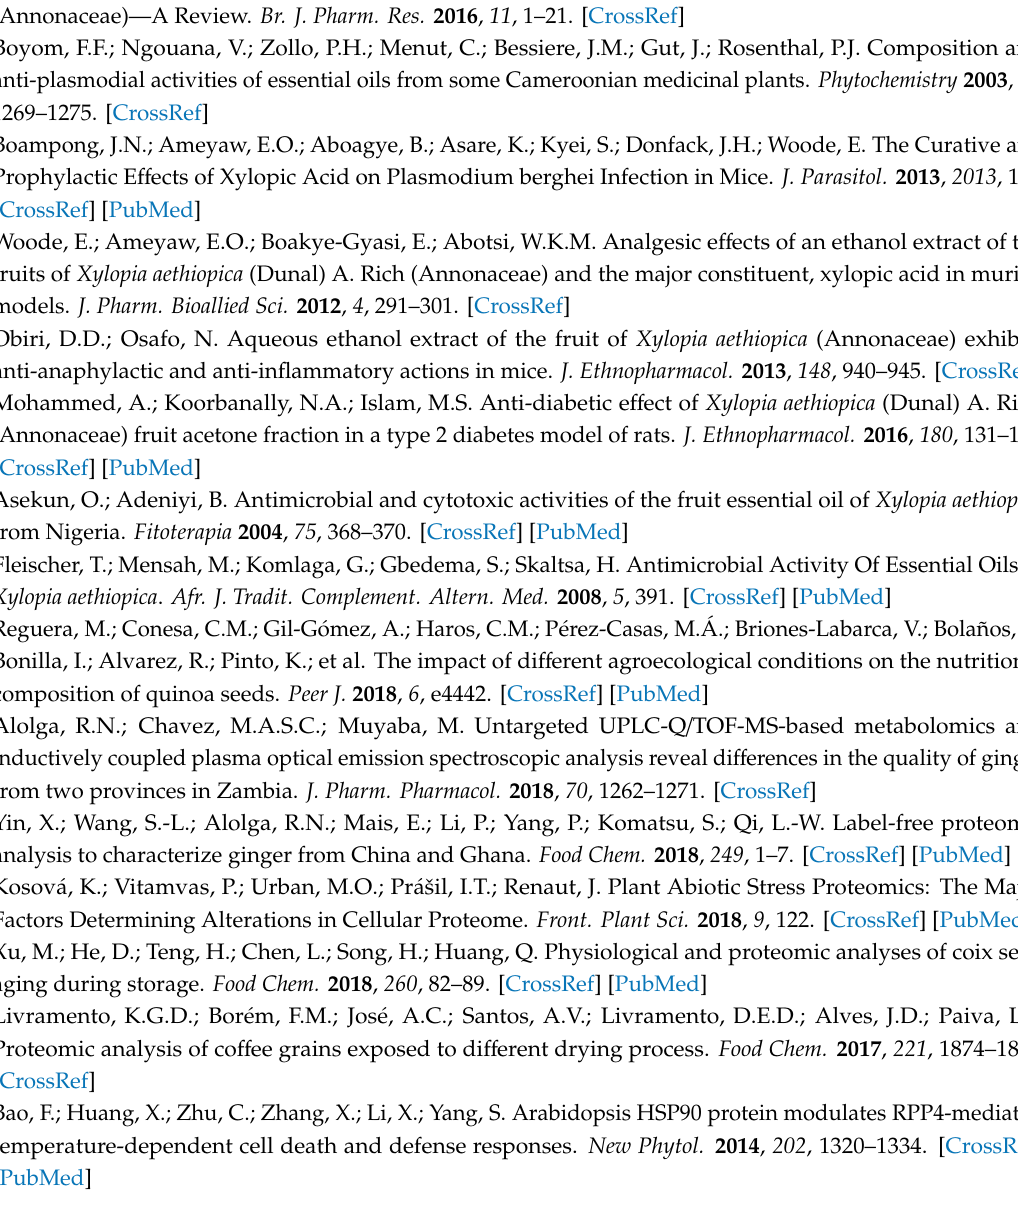
Supplementary Materials: Proteins identified in the seeds of X. aethiopica from Ghana, Table S2: Proteins identified in the seeds of X. aethiopica from